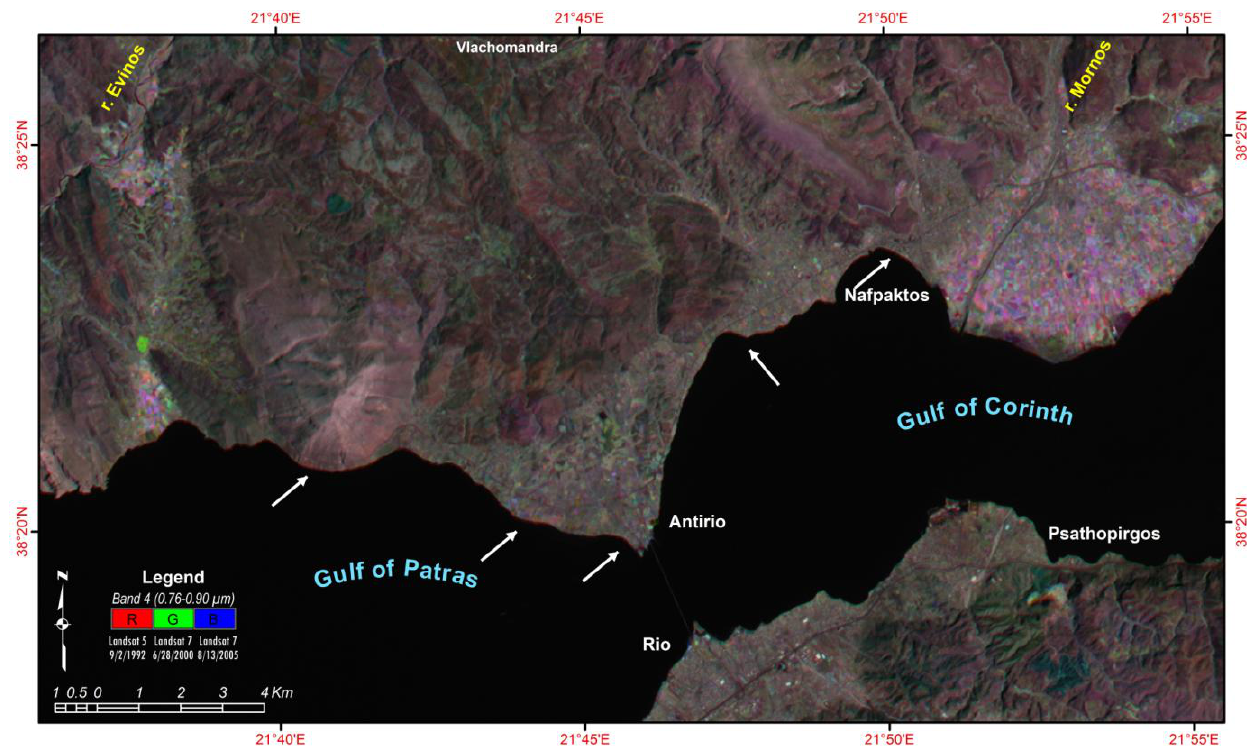
Figure 5. Multi-temporal pseudo-color image produced from layer stacking of Landsat satellite data (Band 4, 0.76 to 0.90 μm) with three different acquisition dates. The high absorbance of water creates a high reflectance contrast along the coastline so that shoreline regression is easily observed and quantified. The white arrows point to alterations of the coastal areas described in the